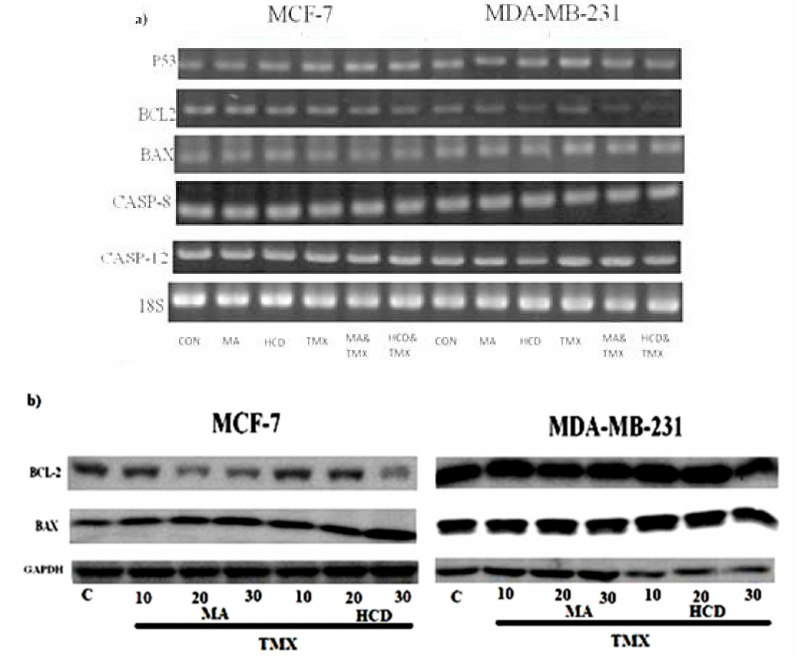
Figure 4. Breast cancer cells were treated with MA or HCD alone or in combination with TMX for 24 h and then analyzed for ( a ) mRNA (p53, Bcl2, Bax, Cas-8, Cas-12); ( b ) MCF-7 and MDA-MB 231 cells were treated with various concentrations of MA and HCD (10, 20, and 30 µ M) for 12 h and further treated with TMX (1 µ M) for additional 12 h and then analyzed for BAX and BCL-2 protein expression. For mRNA expression 18S was used as an internal control and for Western blotting GAPDH was used as an internal control, respectively. Data shown are the mean ± SD values of three independent experiments (* p < 0.05, ** p < 0.01 as compared with the untreated